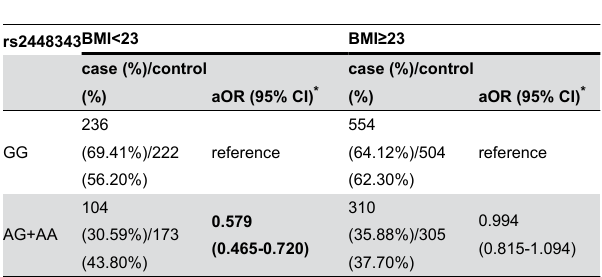
Table 3. Stratified analyses between rs2448343 of CDK1 and breast cancer risk by BMI